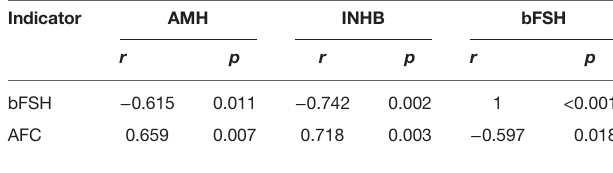
TABLE 1 | Correlation analysis between serum AMH, INHB, bFSH levels and postoperative ovarian reserve. Indicator AMH INHB